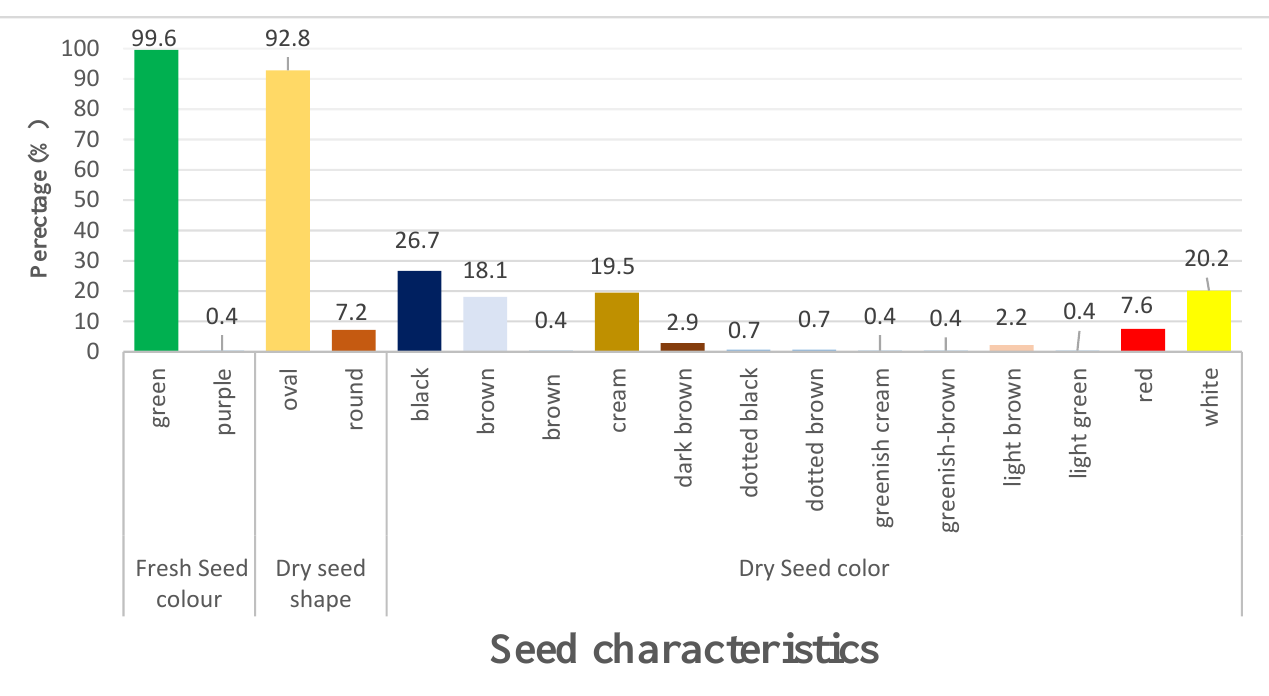
Figure 4. Variation in seed characters of lablab accessions.